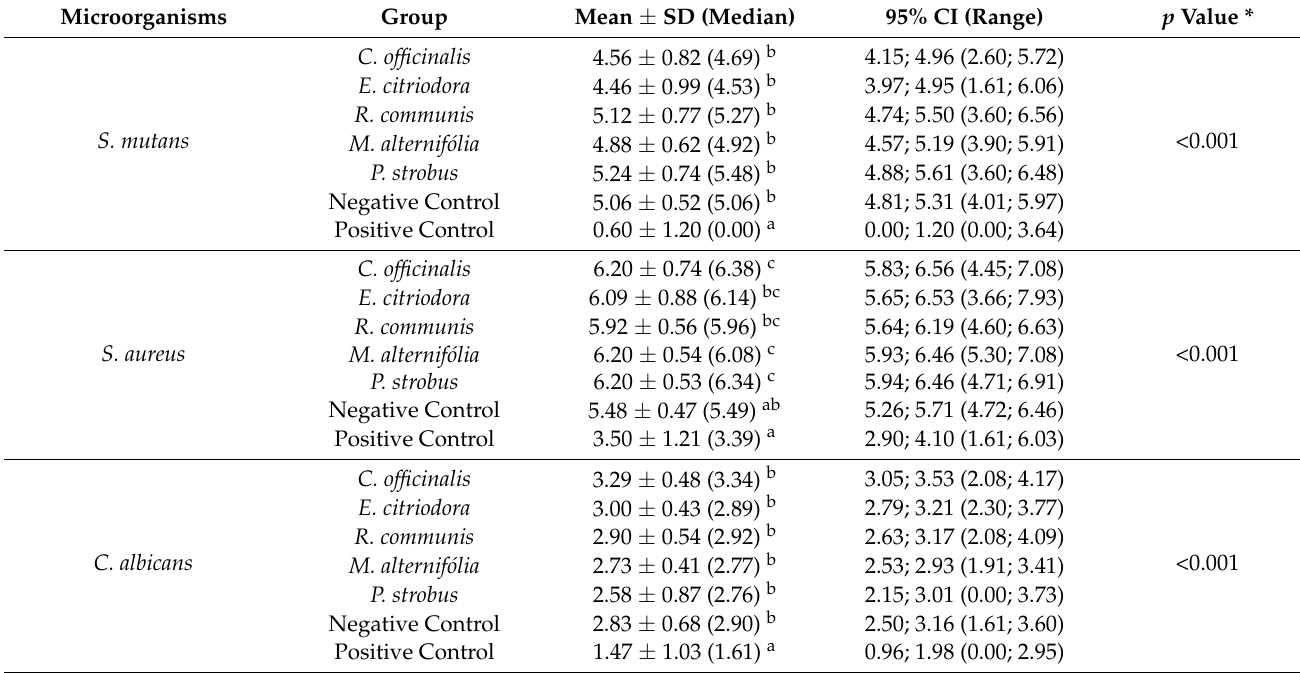
Table 4. Descriptive statistics of log 10 (CFU+1) for S. mutans , S. aureus and C. albicans and statistical comparisons.